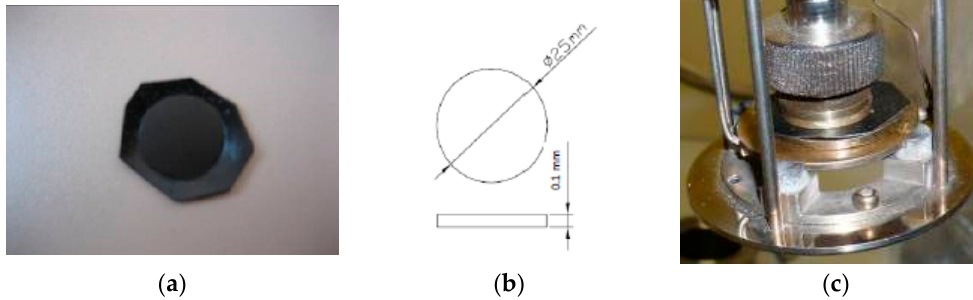
Figure 5. ( a ) Specimens for DEA. ( b ) Dimensions for DEA specimens. ( c ) DEA electrodes.